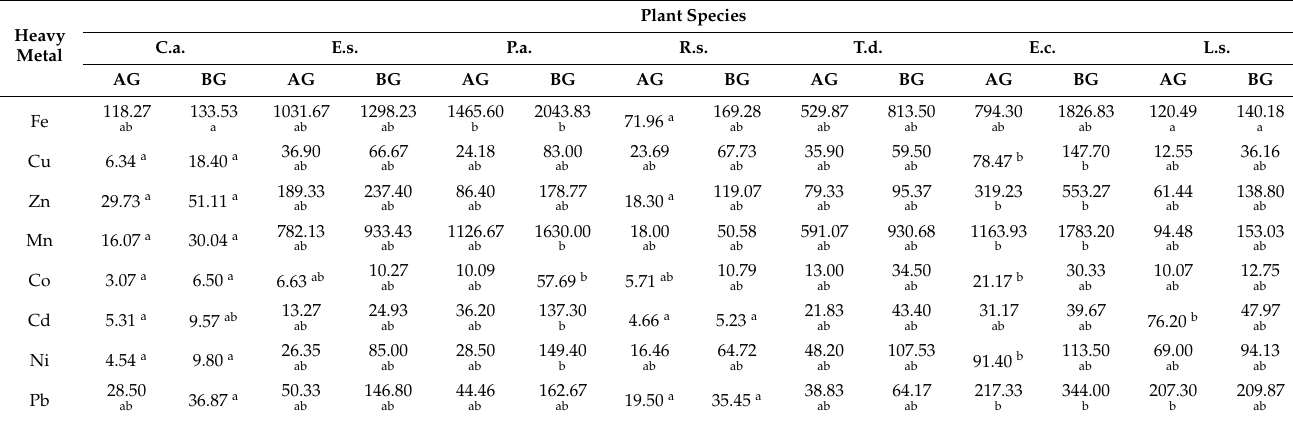
Table 1. Mean values of heavy metals concentration (mg kg − 1 ) in the aboveground (AG) and belowground (BG) tissues of the study plant species collected from the three drains in the Nile Delta of Egypt.